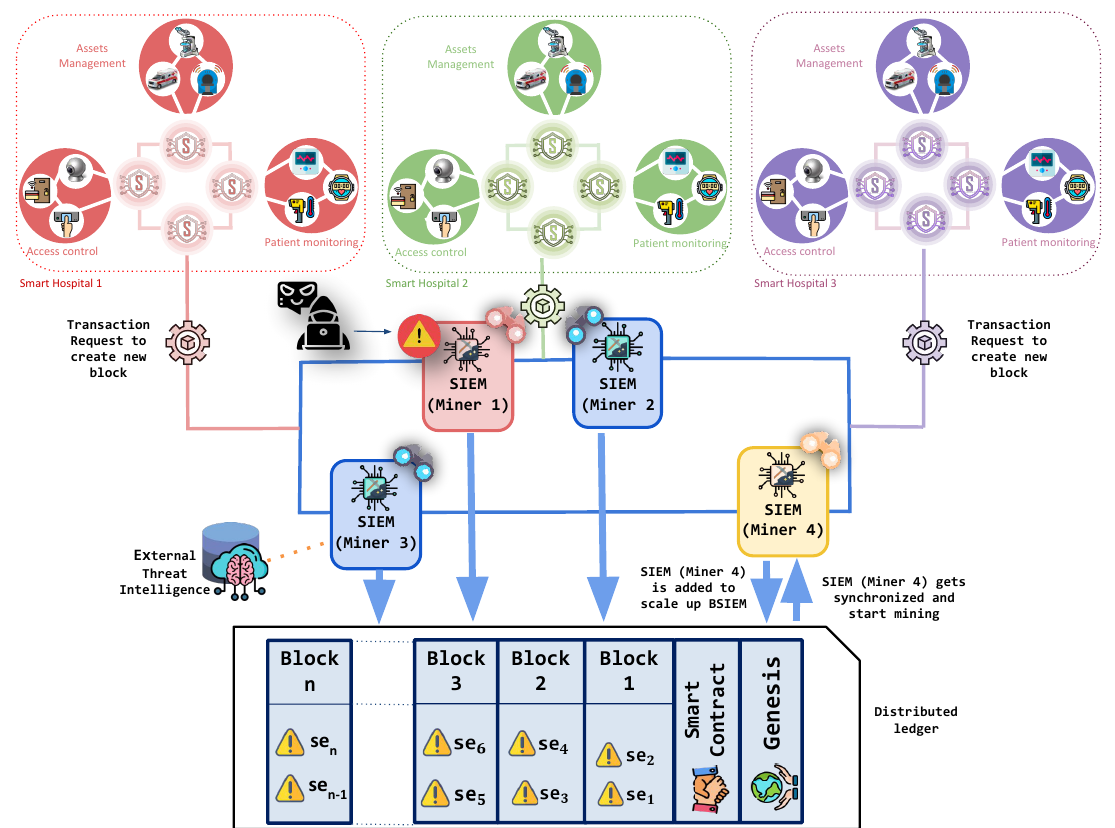
Figure 3. Reduction and increase of SIEMs enabled as miners in